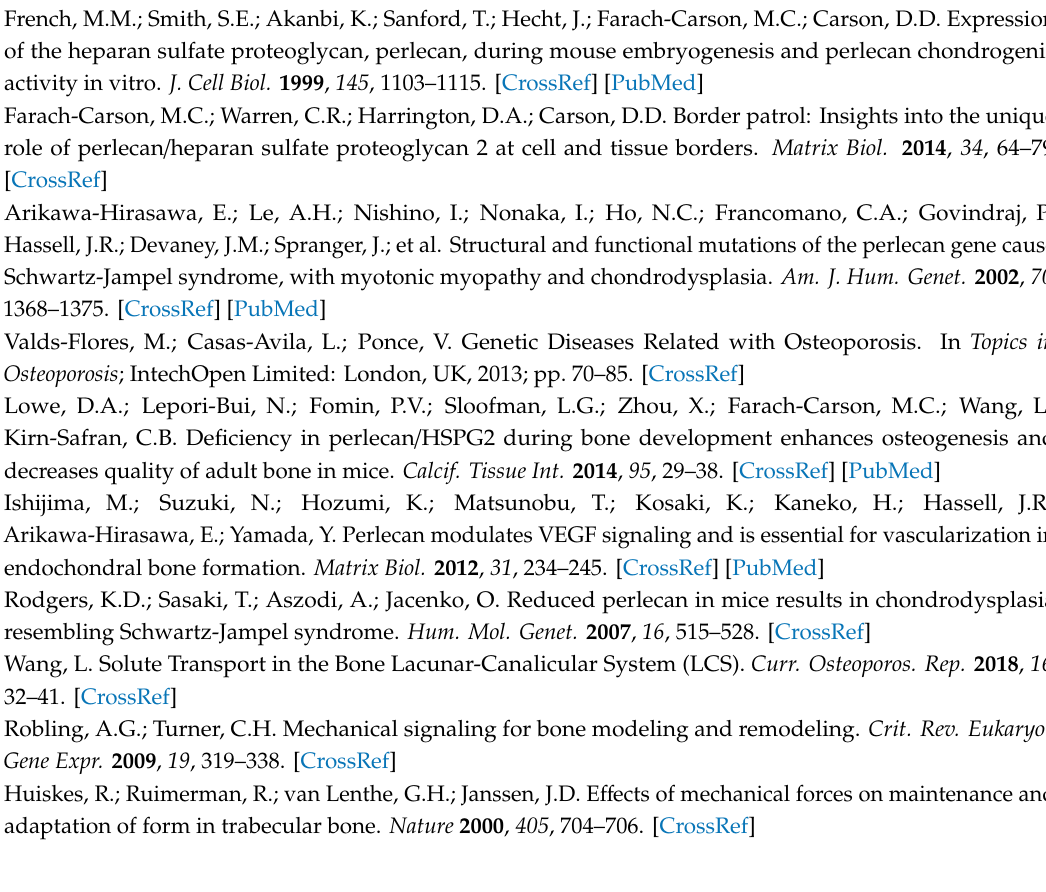
Table S1: RT-qPCR primer sequences; Figure S1: No obvious cortical bone phenotype in Hypo male skeleton; Figure S2: Trabecular bone structure deficit also found in Hypo female skeleton; Figure S3: Di ff erent trabecular responses of WT and Hypo mice to re-ambulation following HLS (presented by comparing WT and Hypo for each disuse / re-loading